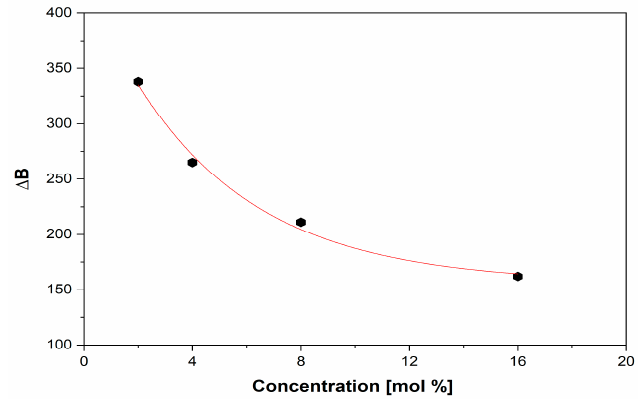
Figure 6. Decrease in the broad line ( ∆ B) with increasing vanadium content.